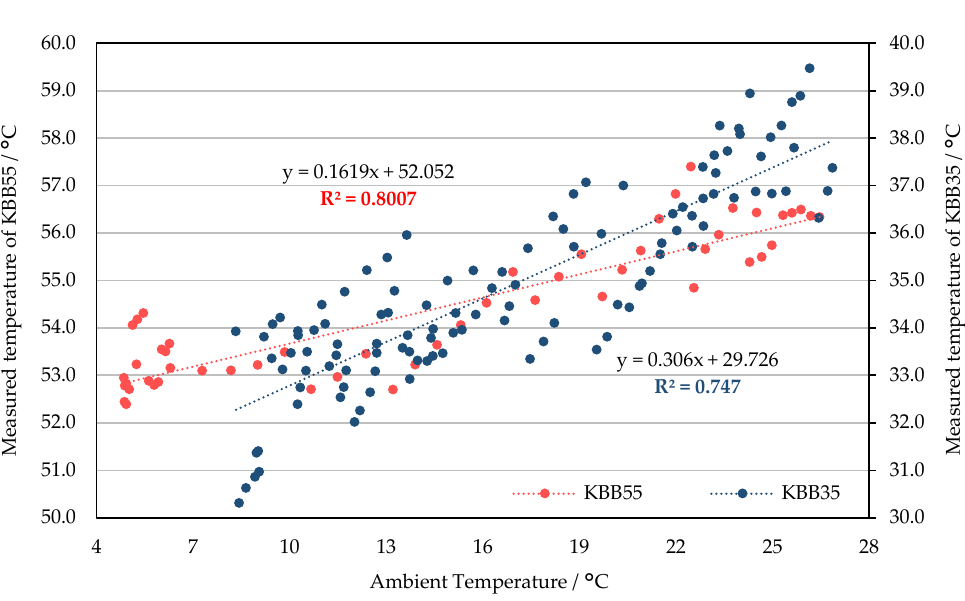
Figure 7. The correlation between the temperature measured by WIRIS 2nd GEN and the ambient temperature for blackbodies at 35 °C (KBB35) and 55 °C (KBB55). P-value was smaller than 0.001 for both.